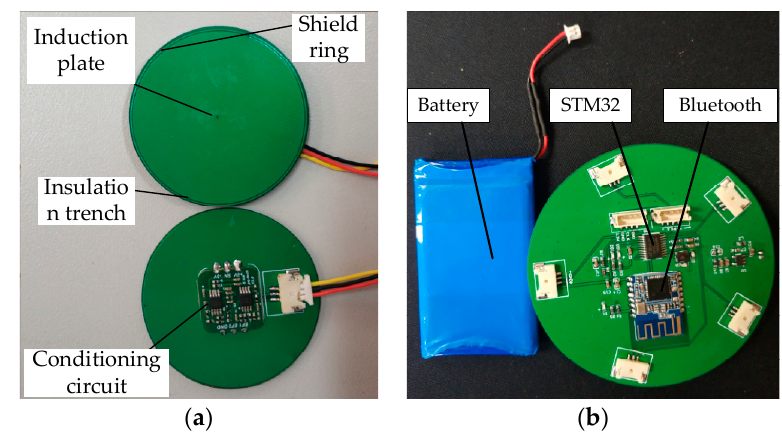
Figure 9. Measuring device: ( a ) electric field sensor; ( b ) controller.